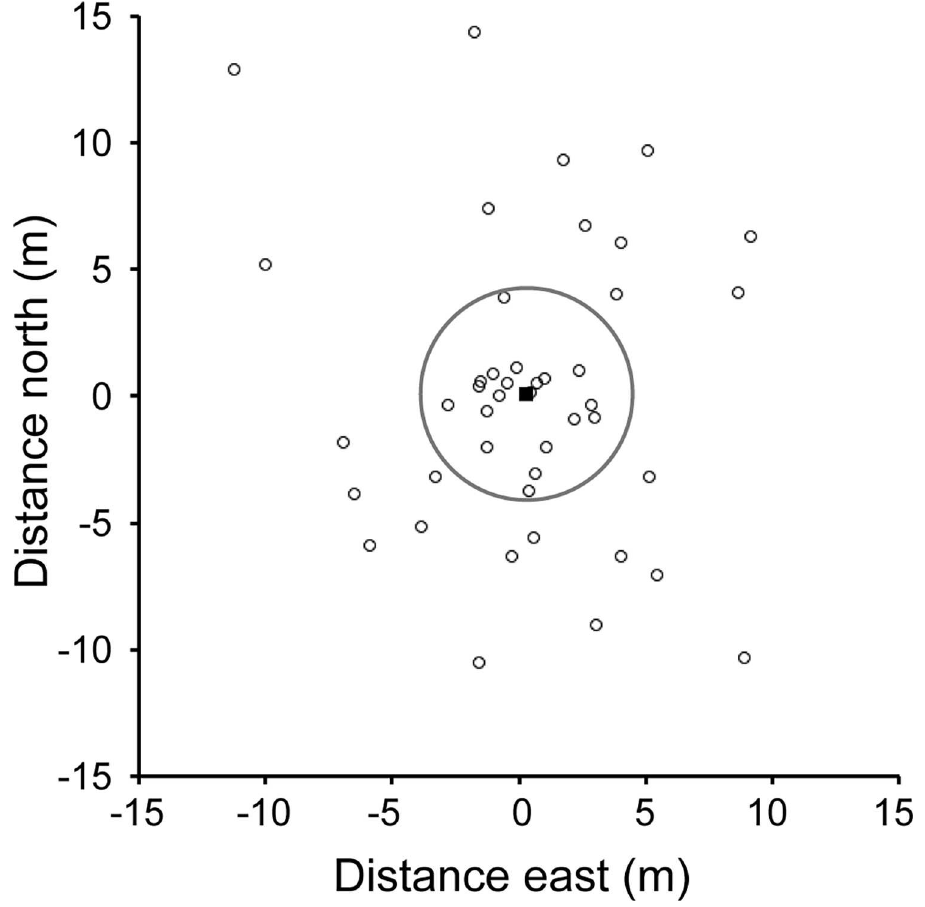
Fig 6. Plot showing spatial difference between global navigation satellite system receiver(GNSS)- and smartphone-derived data points on coastal beaches. Black open circles show the distance between each GNSS observation and the corresponding iPlover observation (S1 Table). The black square is the averagedistance between the GNSS and the smartphonefor the 44 data points, and the gray circle is the one-sigma range around that average